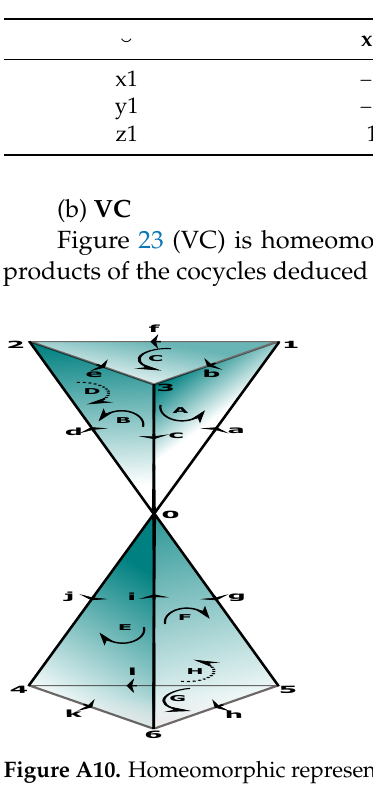
Table A3. Cup product of the cocycles deduced from Figure A9.